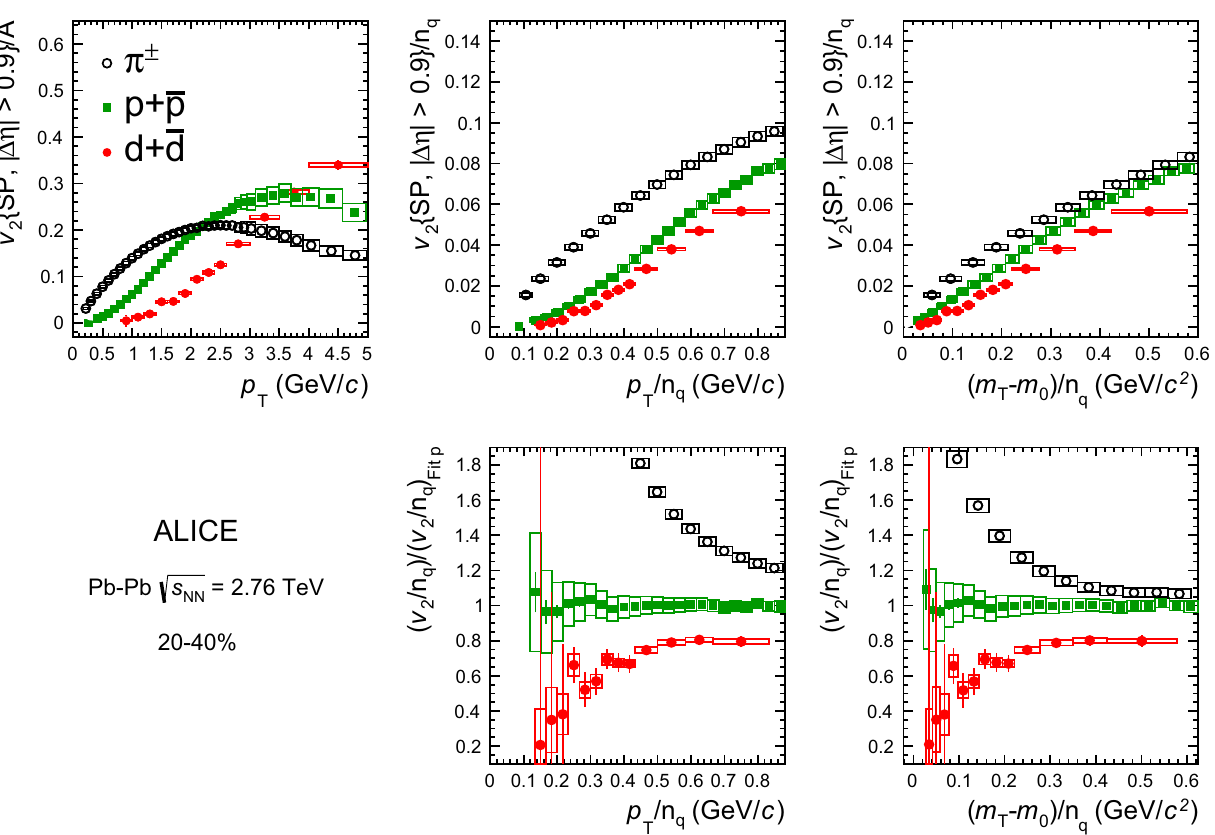
Fig. 6 v 2 of π ± (empty circles), p+p (filled squares) and d+d (filled circles) measured in the 20–40% centrality interval. A detailed description of each panel can be found in the text